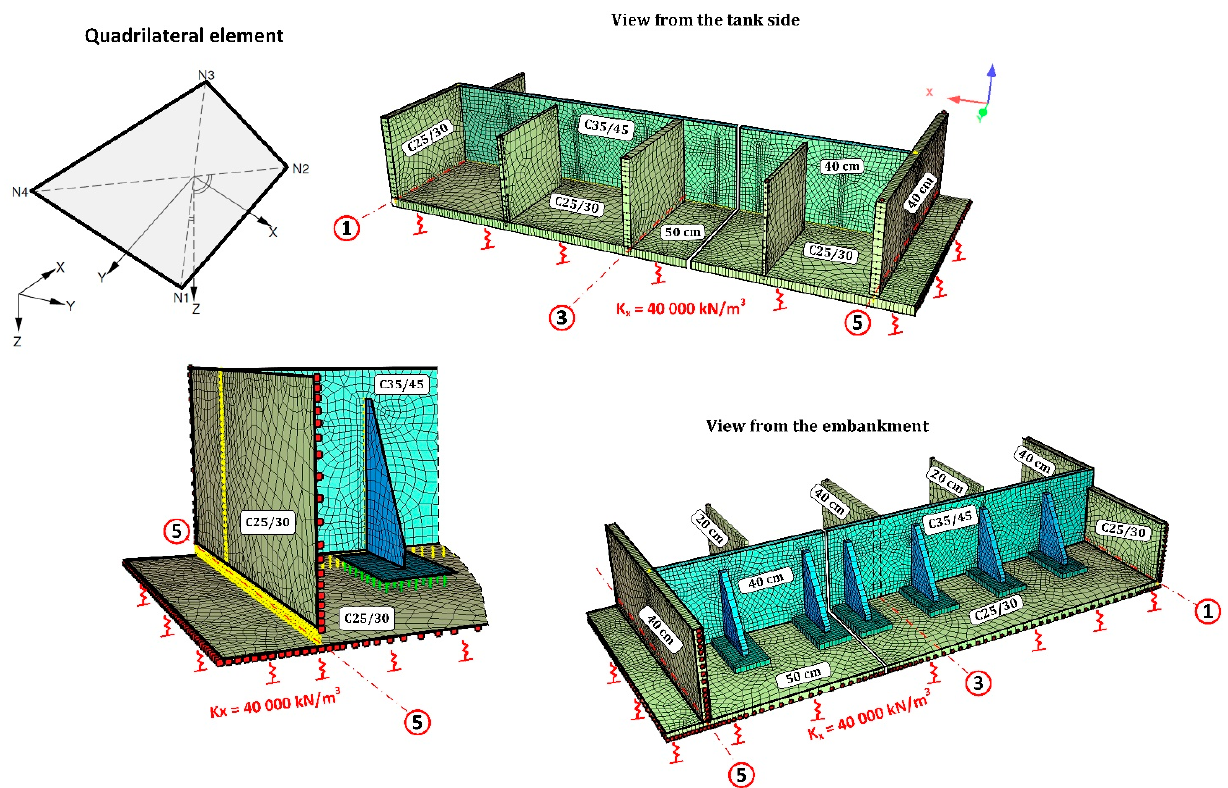
Figure 20. Sketch of the numerical model for verification of the flexural loading of the existing foundation slab.